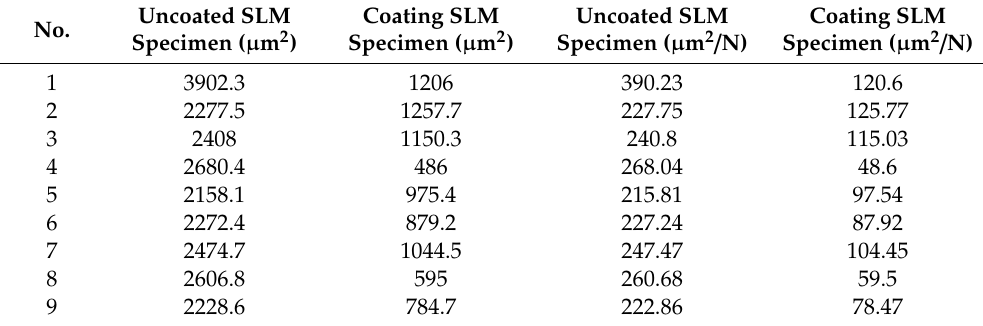
Table 9. Wear areas and wear rates of specimens.